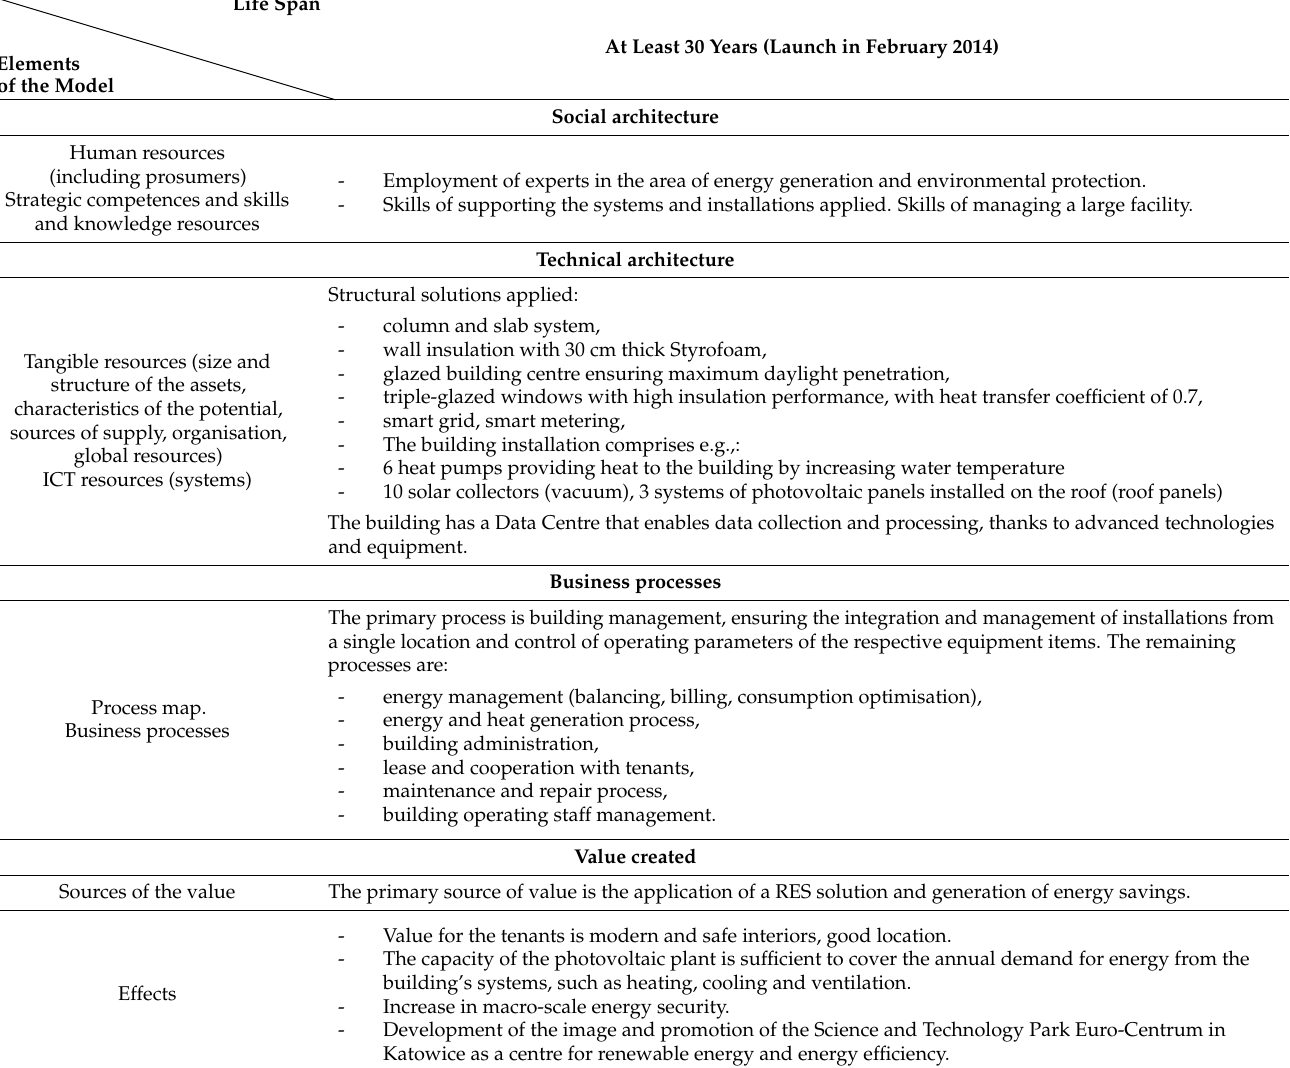
Table 7. Elements and properties of the low-emission office